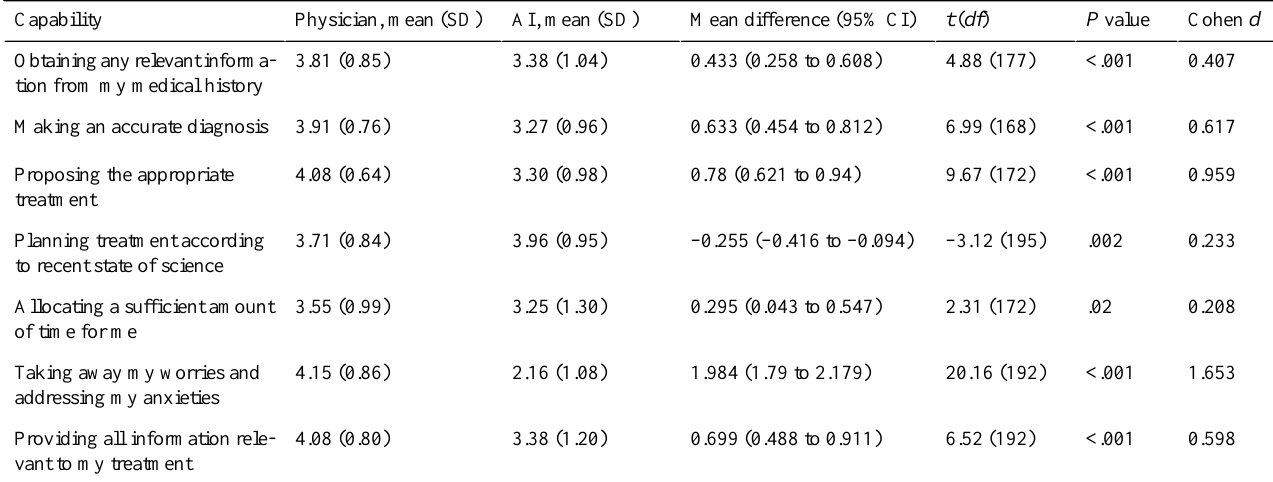
Table 2. Comparison of mean ratings regarding confidence in clinical capabilities of physicians and artificial intelligence (AI).